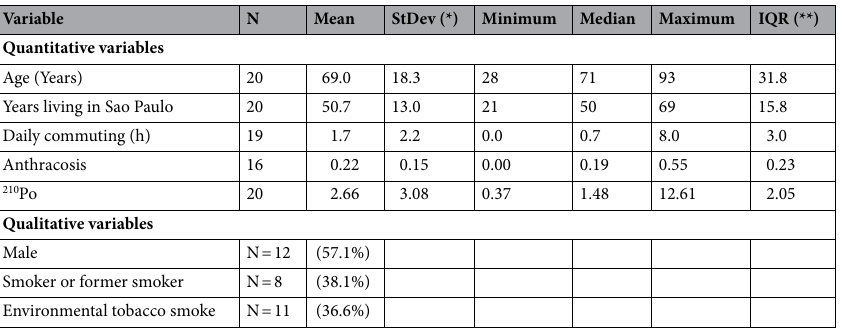
Table 1. Descriptive statistics of the individual characteristics, 210 Po-Lung and anthracosis. (*) standard deviation; (**) interquartile range.